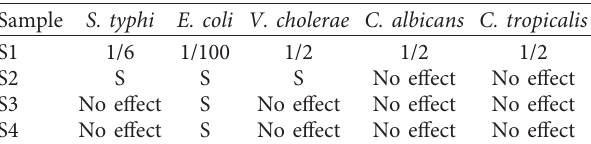
Table 5: Minimum inhibitory concentration (MIC) of vinegar